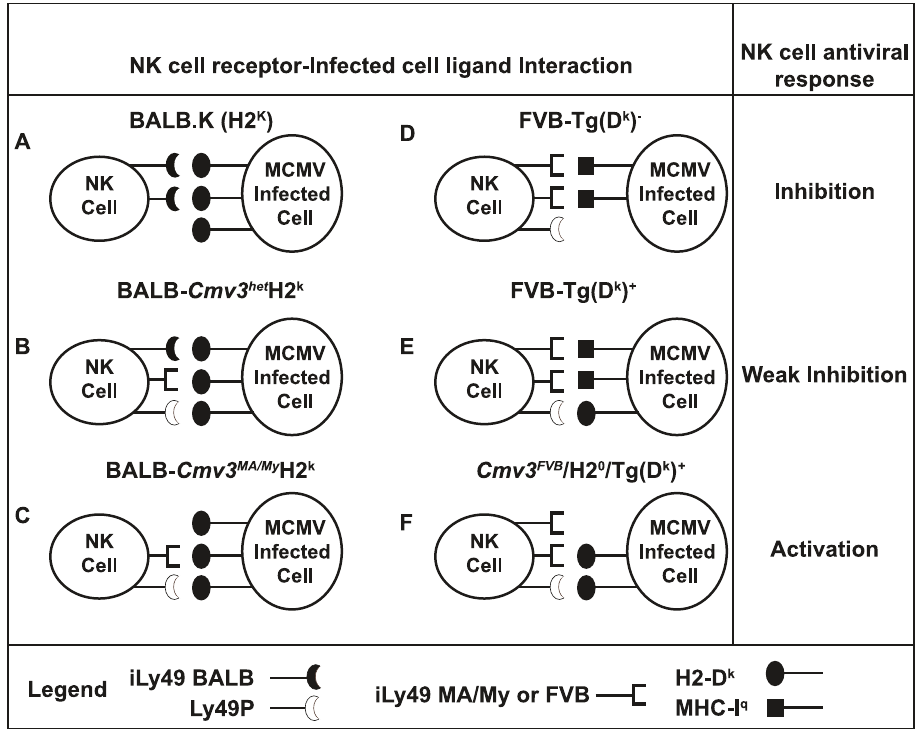
Figure 6. Model of H2 -dependent, Cmv3 -determined NK response against MCMV infection. The strength of Ly49 inhibitory signals and the presence of H2 -D k -mediated activating signals modulate the NK cell response against virus infection. Our set of NKC congenic mice bore different assortments of Ly49 receptors, but carried an identical H2 k resistance haplotype. (A) NK cells from BALB.K mice had a high frequency and strong binding of inhibitory Ly49 receptors, which rendered BALB.K mice most susceptible to MCMV infection. (B) NK cells from congenic BALB. Cmv3 het H2 k mice carried one copy of the activating Ly49p gene, which can activate the Ly49P/ H2 -D k / m04 axis, allowing for intermediate viral loads in heterozygous mice. (C) NK cells from BALB. Cmv3 MA/My H2 k mice had the lowest frequency (and/or weakest binding) of inhibitory Ly49 receptors for H2 k molecules and the highest frequency of activating Ly49P + NK cells, resulting in strong control of MCMV infection. Our set of F 3 mice carried different MHC-I components, but an identical Cmv3 -resistance haplotype, encoding seven inhibitory and three activating Ly49 receptors, including Ly49P. (D) Engagement of inhibitory receptors in FVB-Tg(D k ) 2 mice resulted in inhibition of the NK cell response against MCMV. (E) In FVB-Tg(D k ) + mice, activating signals mediated by the engagement of Ly49P by H2 -D k / m04 , in the presence of inhibitory signals elicited by H2 q molecules, provided a marginal enhancement of the NK cell response, and intermediate virus control. (F) In the absence of inhibitory H2 q signals, H2 -D k - dependent activation of NK cells was more efficient, which resulted in strong control of MCMV infection in Cmv3 FVB / H2 0 /Tg(D k ) +